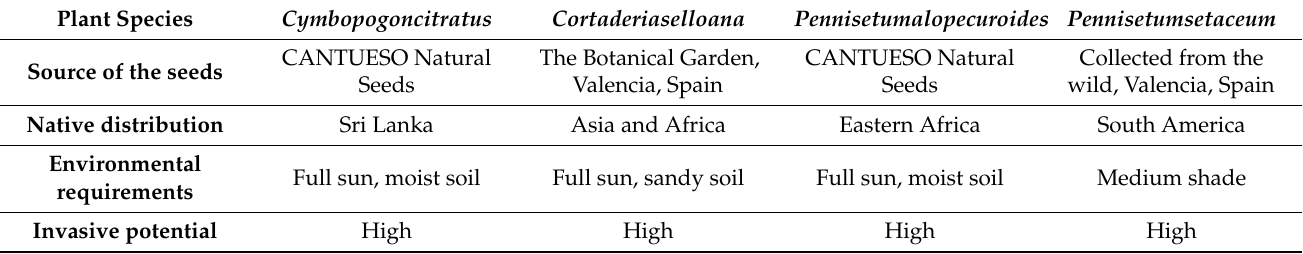
Table 6. Source of the seeds, native distribution, environmental requirements and invasive potential of the tested species